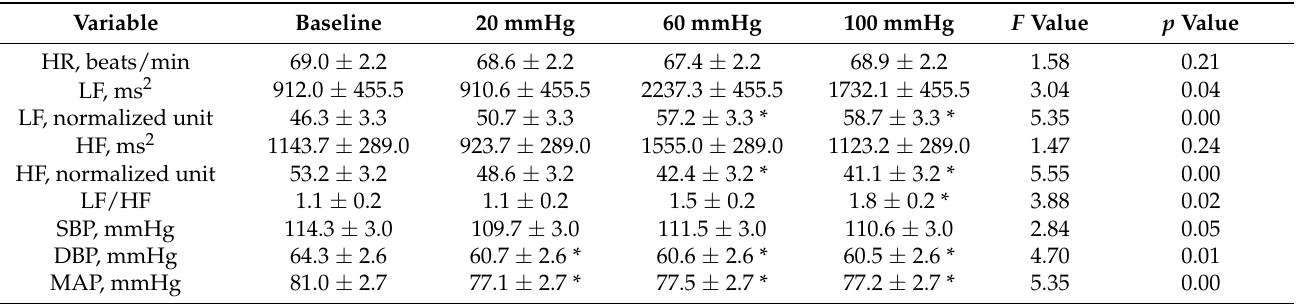
Table 1. Changes in measured heart rate variability and blood pressure variables for the three venous occlusion